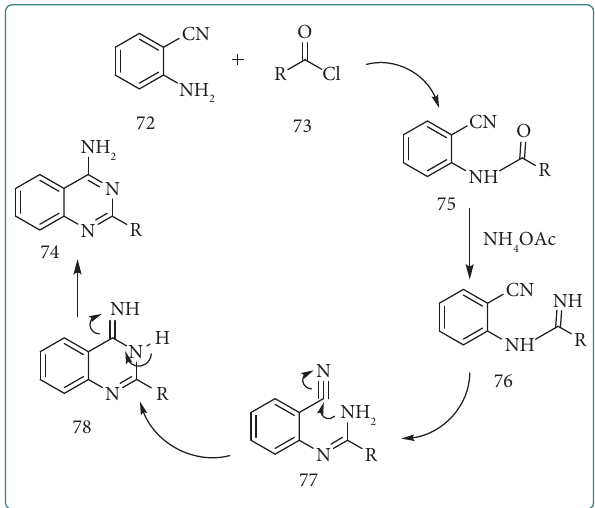
Figure 10: Te proposed mechanism for the synthesis of 4-ami- noquinazolines using HPAs as